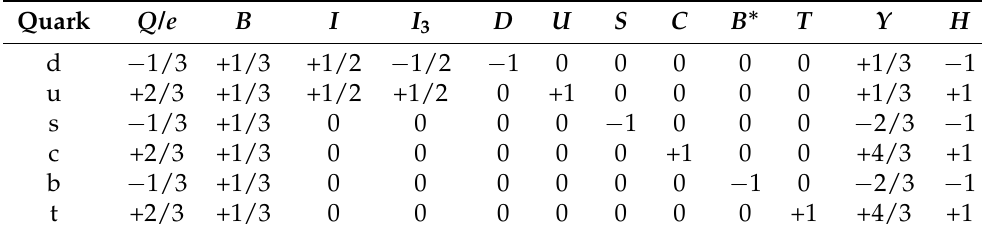
Figure 1. Weight diagrams for hadrons including u, d and s quarks. Upper panel: the meson nonet. Lower panel: the baryon octet (green lines) and decuplet (gray shadow). Table 1. Additive quantum numbers of quarks. Antiquarks have additive quantum numbers with the same absolute values as quarks but the opposite sign of quarks except that antiquarks have same I as